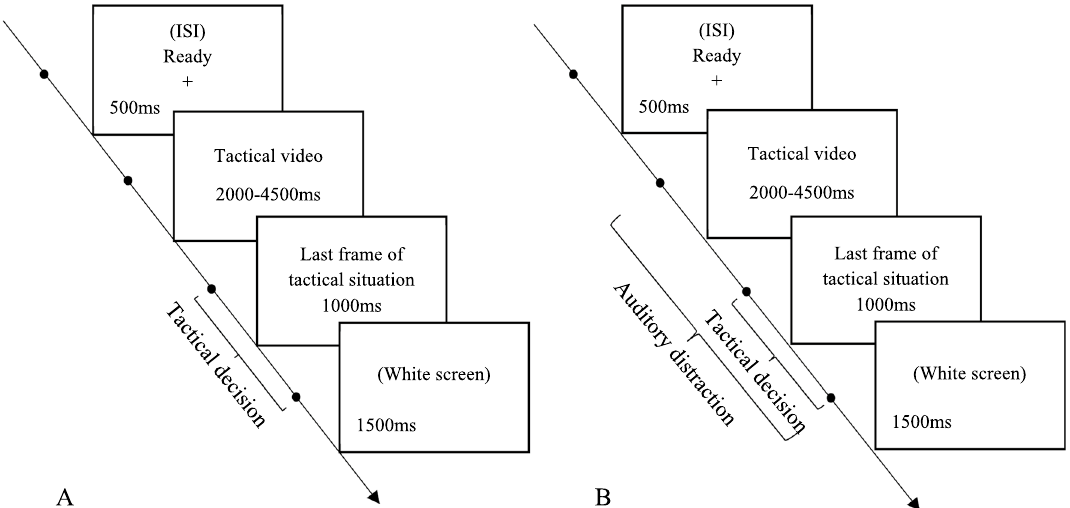
Fig. 1 Illustration of a trial sequence from ( A ) tactical decision-making task without distraction and B tactical decision-making task under auditory distraction. Note. ISI interstimulus =